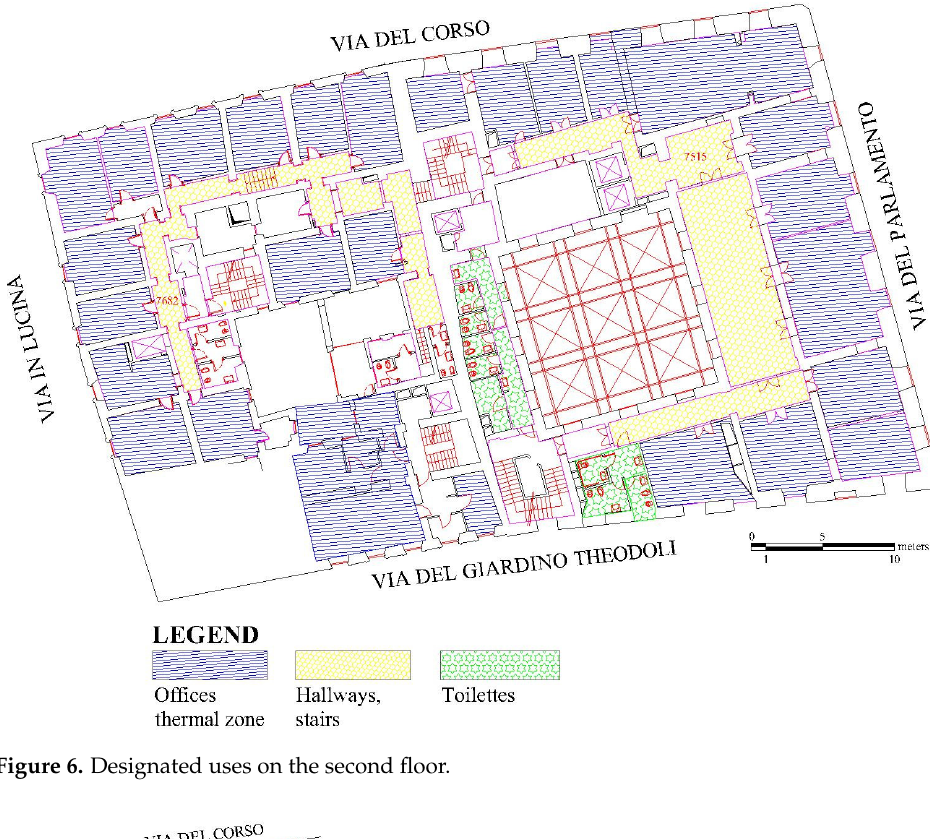
Figure 6. Designated uses on the second floor.